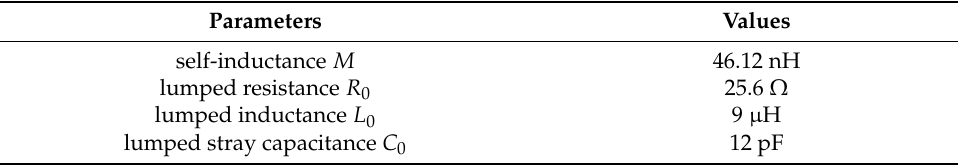
Table 2. Lumped parameter of coil. Table 2. lumped parameter of coil.